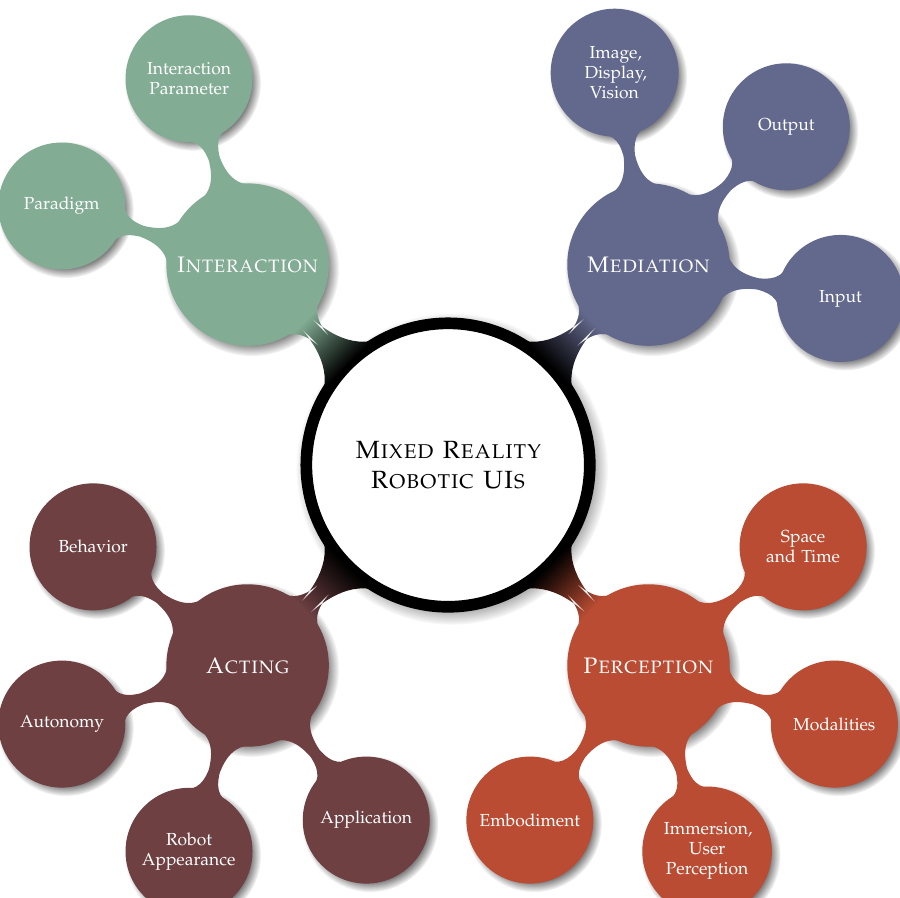
Figure 6. The overall structure of the mixed reality robotic user interface taxonomy. MRRUIs are directly shaped by the aspects of interaction, mediation, perception, and acting . These groups including their relevant subcategories and containing factors generate the IMPAct framework for MRRUI classification and